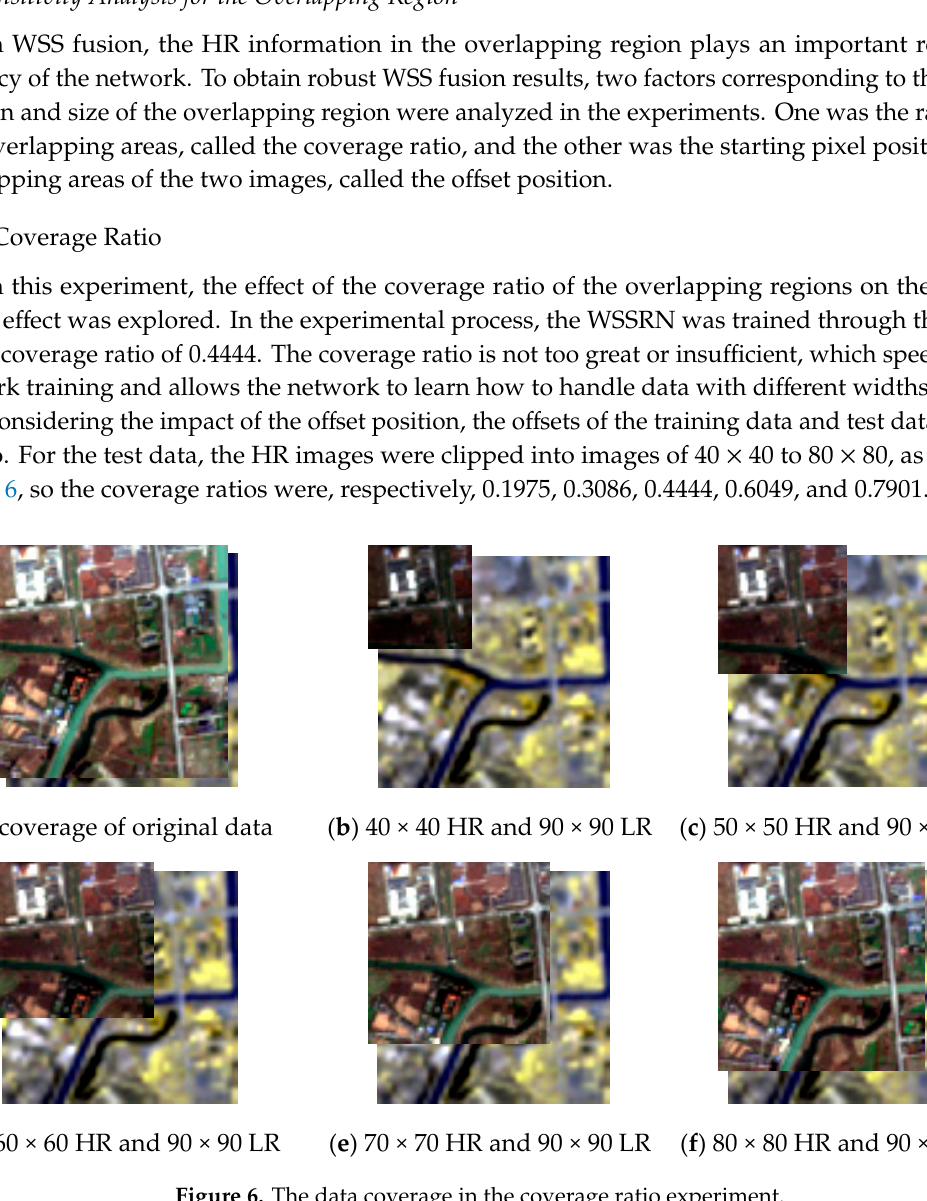
Figure 6. The data coverage in the coverage ratio experiment.